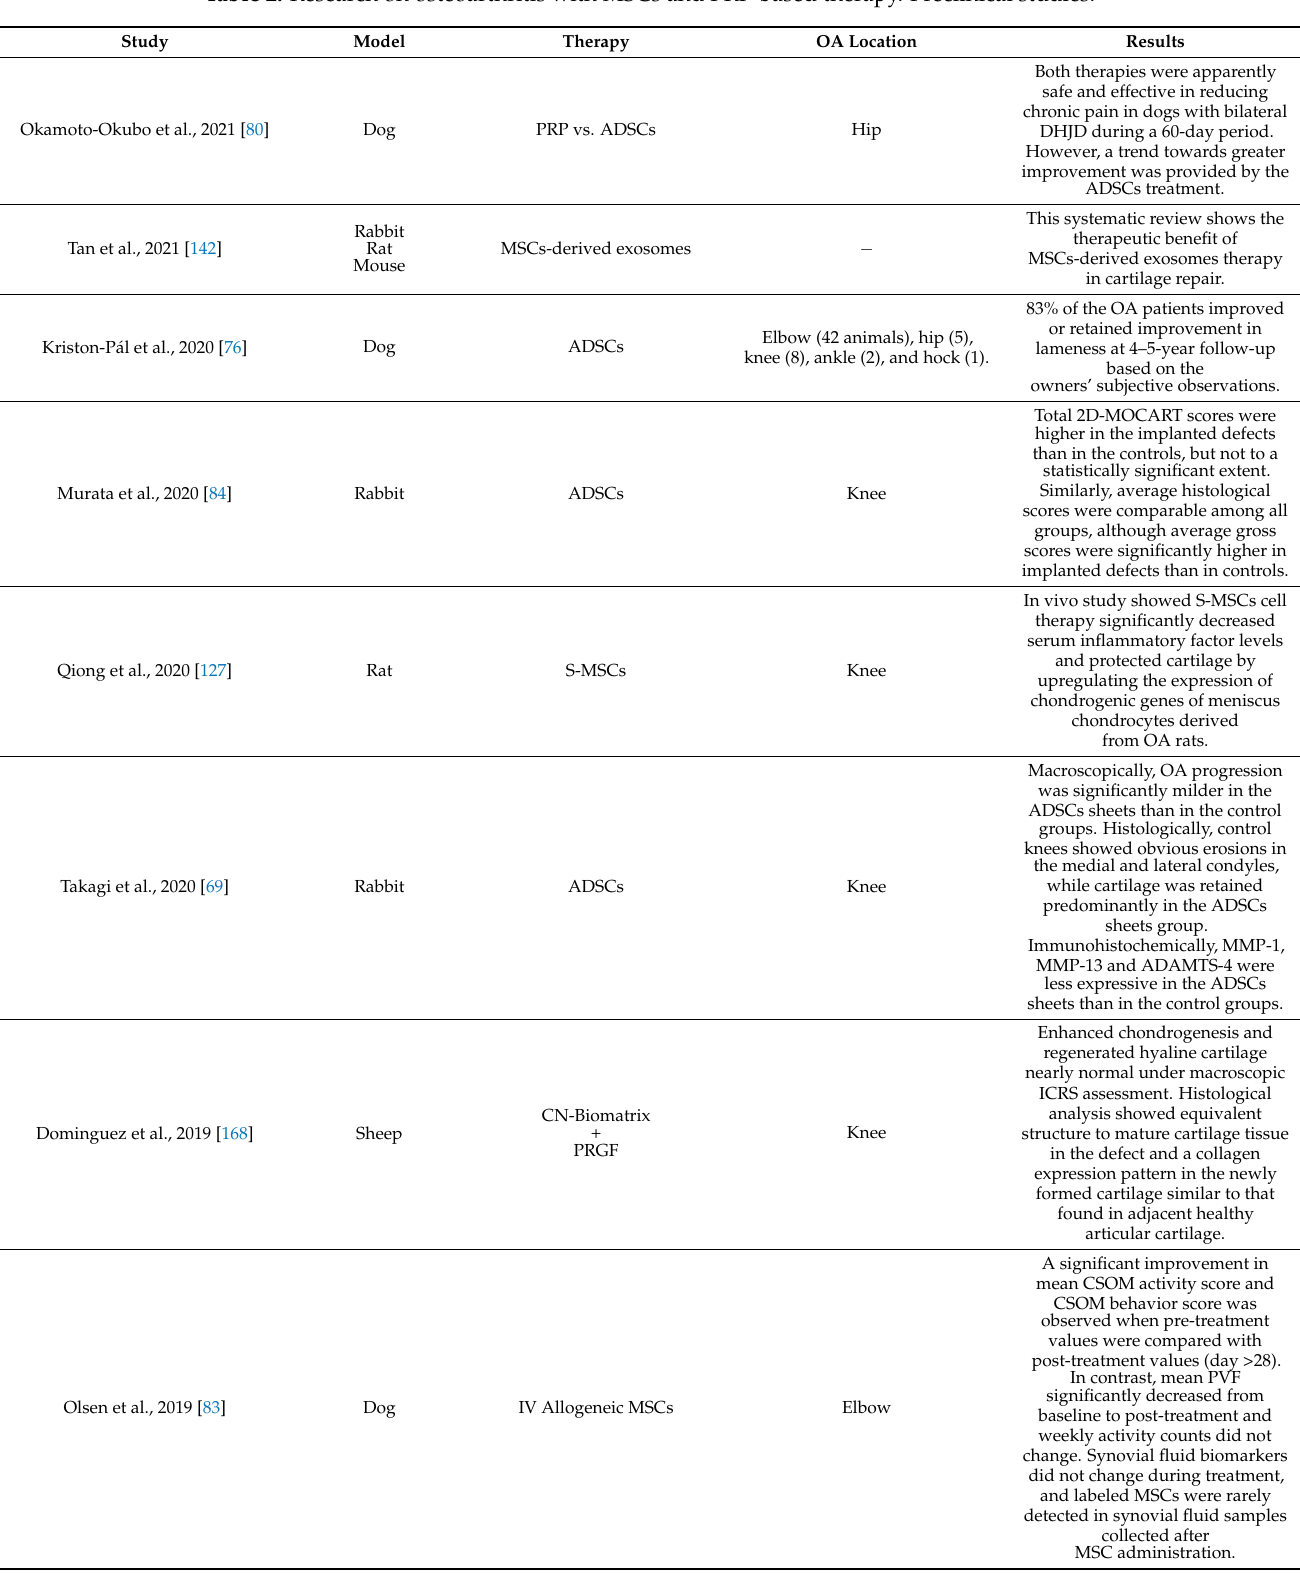
Table 2. Research on osteoarthritis with MSCs and PRP-based therapy. Preclinical